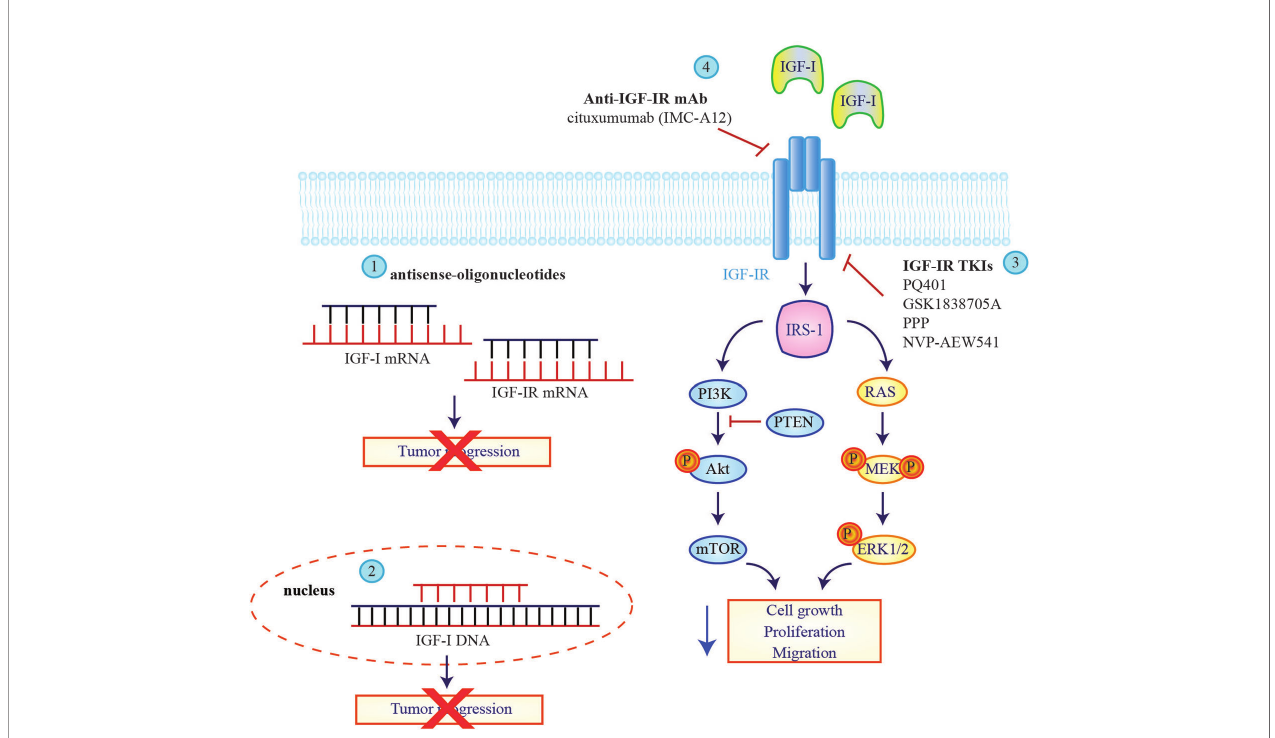
FIGURE 2 | Therapeutic strategies to block insulin-like growth factor signaling in glioblastoma multiforme cells. Approaches tested to inhibit insulin-like growth factor (IGF) signaling in glioblastoma (GBM) patients include antisense oligonucleotides against IGF-I and IGF-IR mRNA (1) or the employ of IGF-I triple helix gene therapy (2) to induce a block of tumor progression. IGF-IR direct inhibitors, IGF-IR TKIs (3) and IGF-IR mAbs (4) are also tested on GBM cell lines to reduce IGF downstream